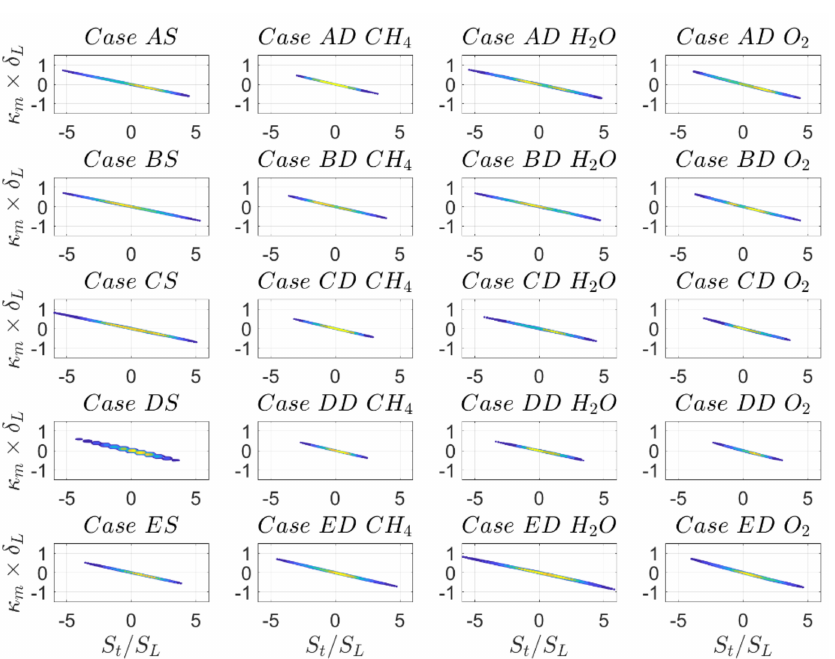
Figure 14. Joint PDF of normalised tangential diffusion component of displacement speed S t / S L and normalised mean curvature κ m × δ L on c = 0.8 progress-variable isosurface for top to bottom cases A–E for (1st column) SC and (2nd to 4th column) DC simulations for reaction progress variable based on CH 4 , H 2 O,O 2 mass